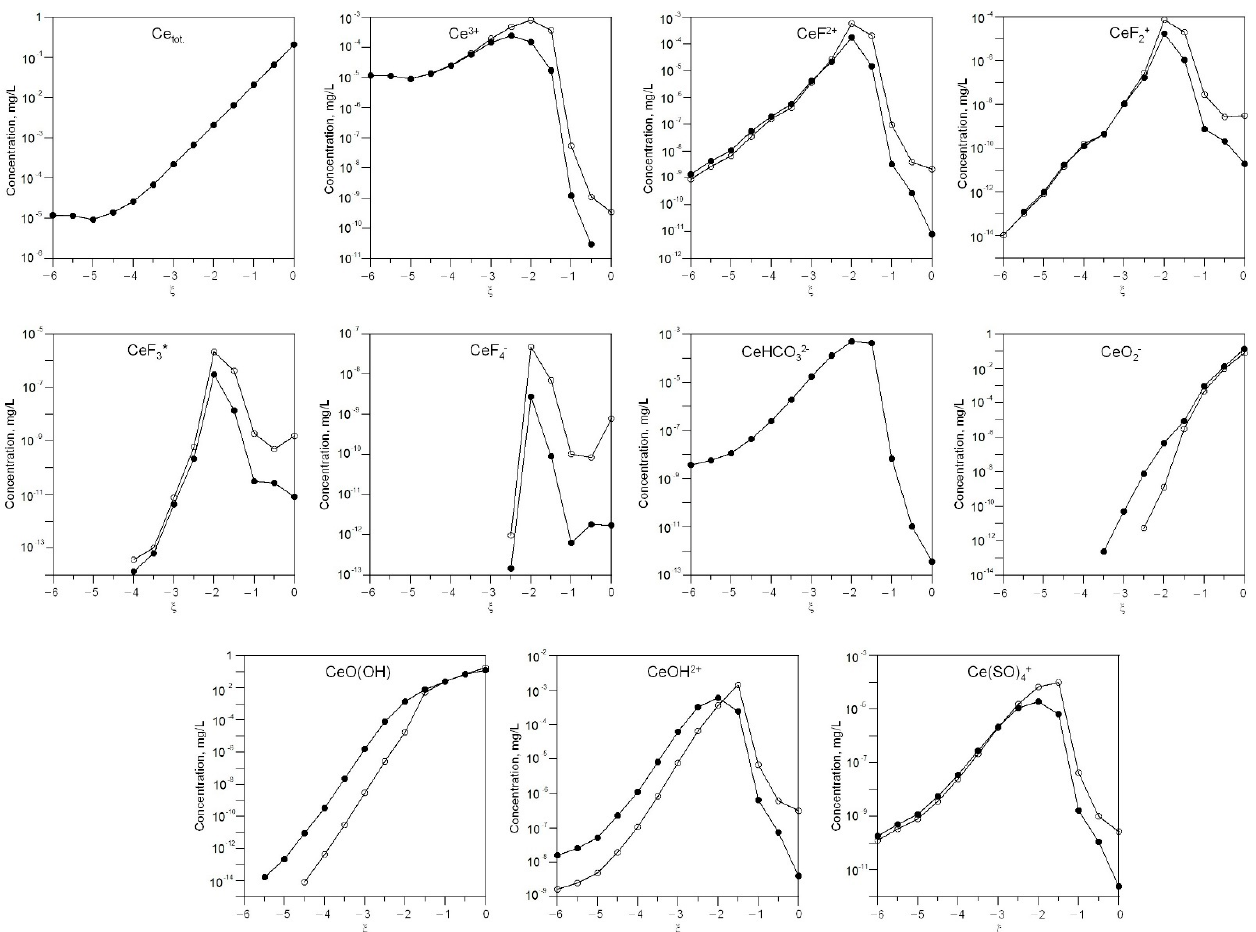
Figure 3. Change in the concentrations of dissolved cerium depending on ξ at 3 °C (white) and 20 °C (black).